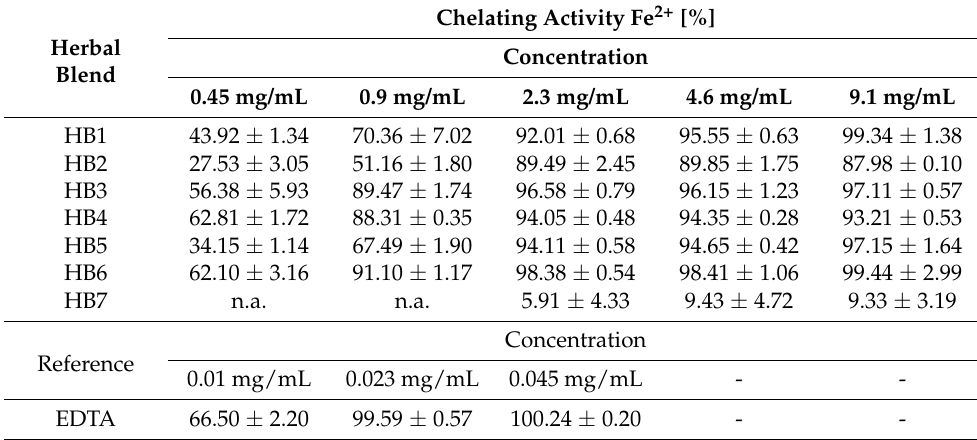
Table 7. Chelating activity of tested herbal infusions.